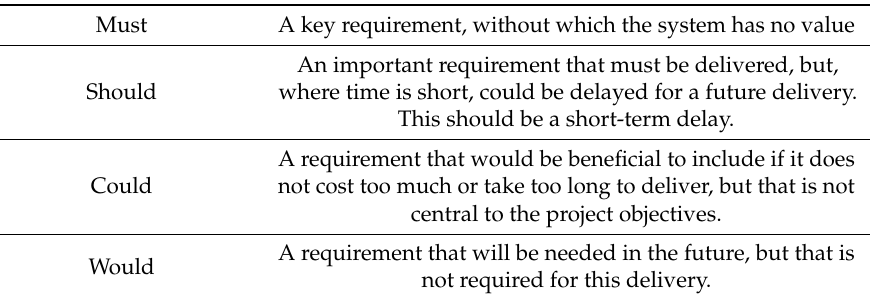
Table 3. MoSCoW priority scale description.